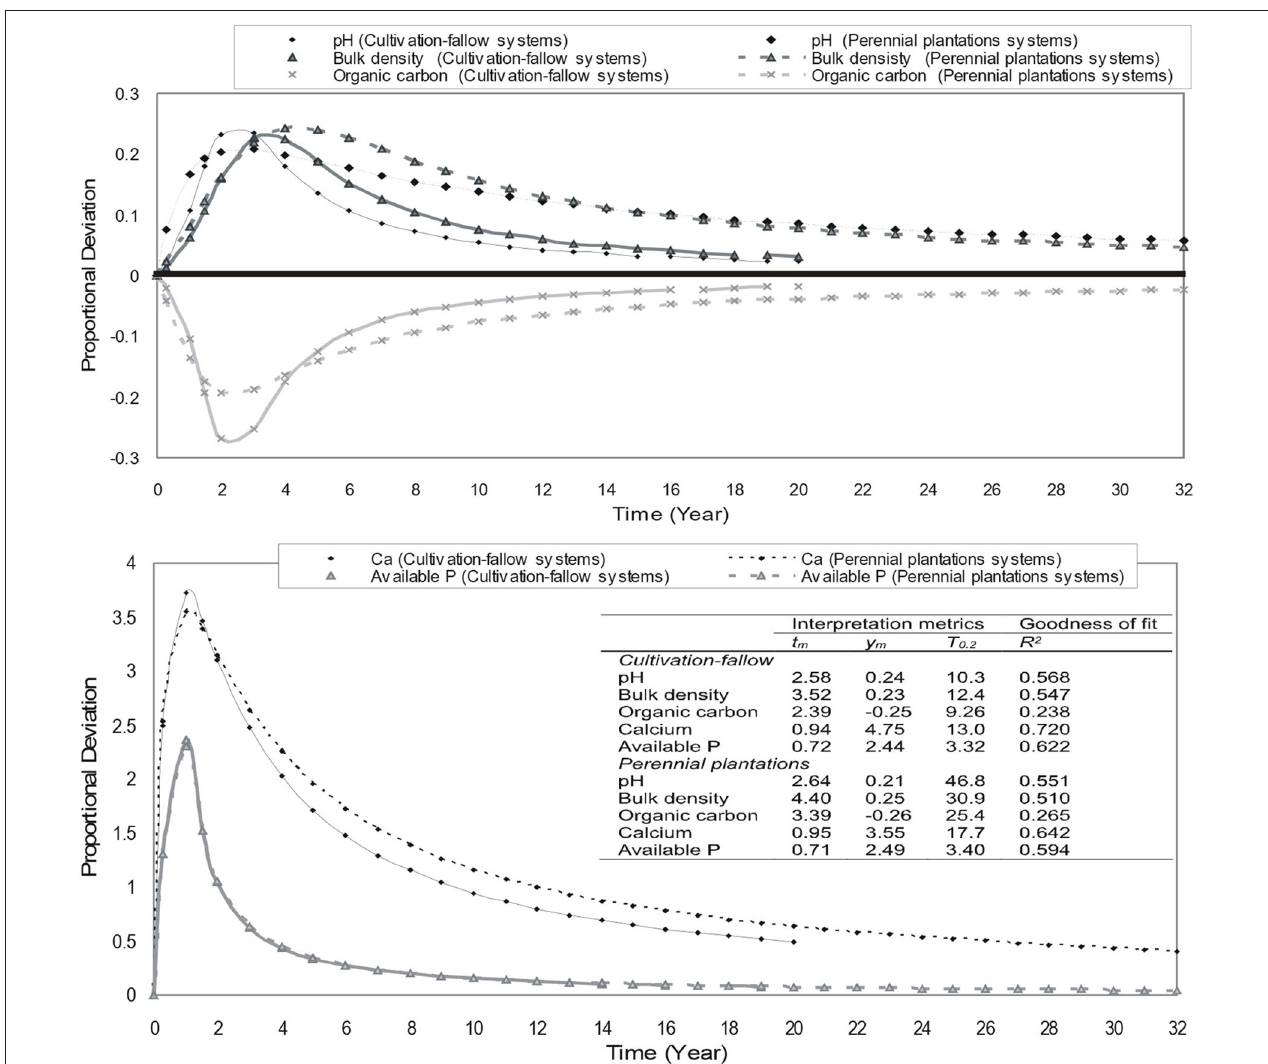
FIGURE 6 | Linear/quadratic fractional rational functions fitted to soil properties (0–10cm) dynamics under two land use chrono-sequences (food cropping-fallow system and perennial plantation) as shown by proportional deviations from the reference under primary forest over time.